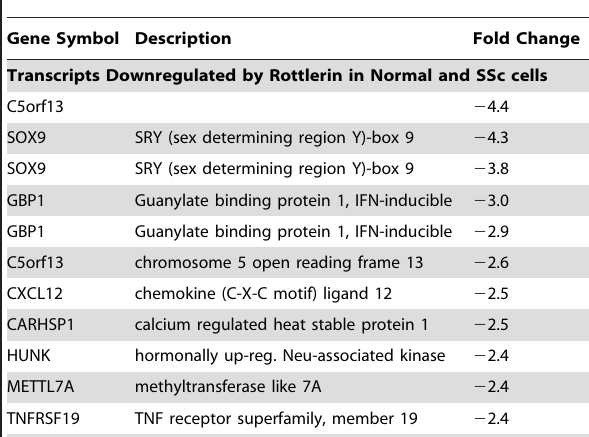
Table 2. Selected upregulated rottlerin responsive transcripts.